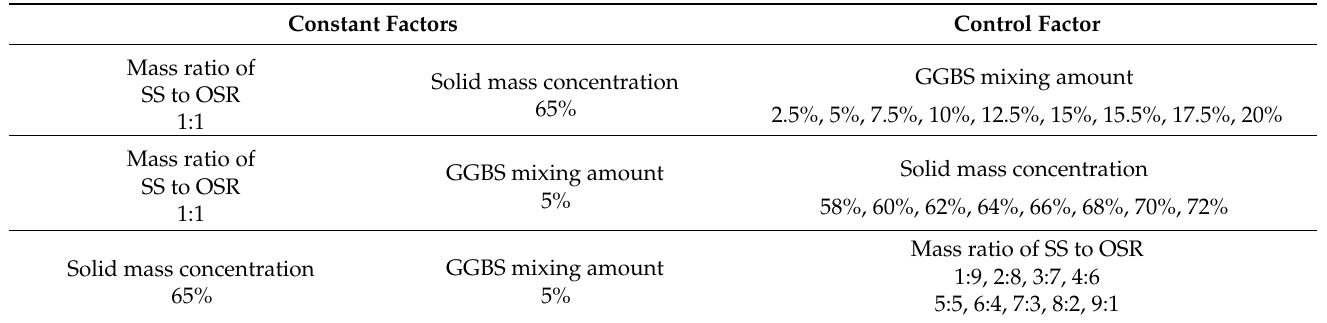
Table 1. Design of single-factor